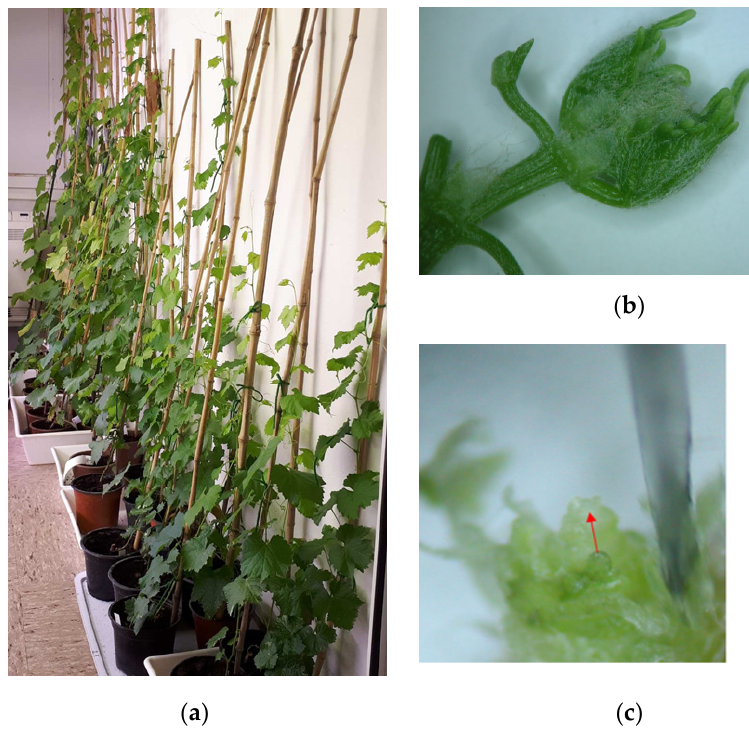
Figure 6. ( a ) In vivo thermotherapy; ( b ) segment prepared after in vivo thermotherapy for meristem isolation; ( c ) grapevine meristem.